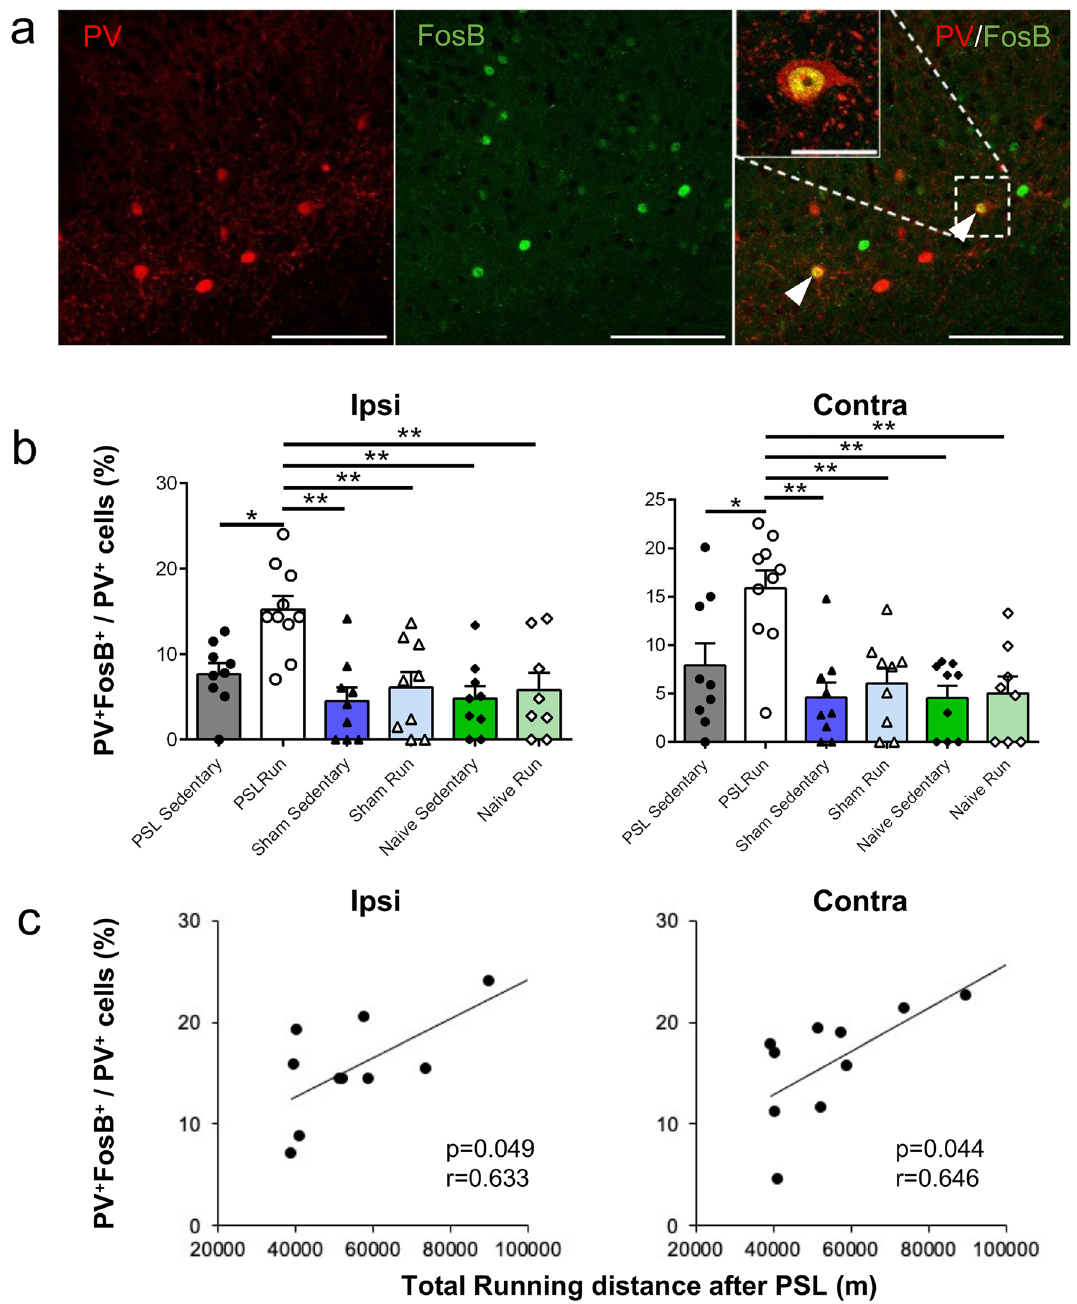
Figure 5. Voluntary running induces activation of PV + interneurons in the vHPC-CA1. ( a ) Representative photomicrographs showing PV (red) and FosB (green) immunoreactivities in the vHPC-CA1 in PSL-Runner mice. Many PV + FosB + neurons (arrowheads) were detected in PSL-Runner mice. Scale bar = 100 mm. An enlarged PV + FosB + neuron is shown in the left upper corner. Scale bar = 25 mm. ( b ) Bar charts showing the proportion of PV + FosB + cells in the vHPC-CA1. The proportion of PV + FosB + cells in PSL-Runner mice is significantly higher than in other groups. Bars represent mean ± SEM. A two-way analysis of variance followed by Tukey’s post hoc-test was used to compare the proportion of PV + FosB + cells among the experimental groups. *p < 0.01, **p < 0.001. ( c ) Relationship between the proportion of PV + FosB + cells and the total running distance after PSL surgery in PSL-Runner mice. Significant positive correlations were observed in both the ipsilateral (p = 0.049, r = 0.633, n = 10) and the contralateral sides (p = 0.044, r = 0.646, n = 10). PSL partial sciatic nerve ligation, vHPC ventral